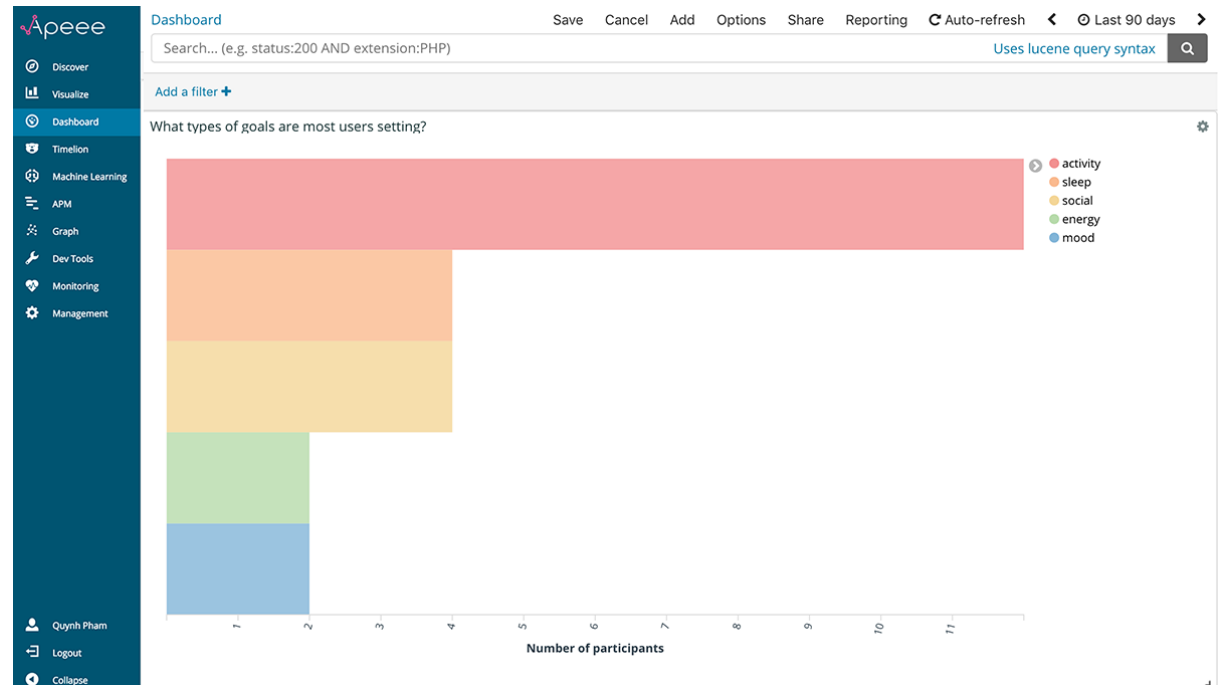
Figure 6. The analytic indicator for “what types of goals are most users setting?,” visualized through APEEE as a horizontal bar chart. APEEE: Analytics Platform to Evaluate Effective